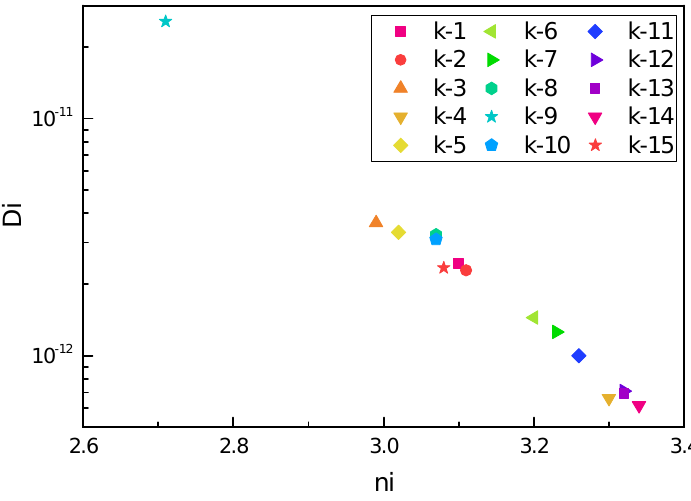
Figure 12. Values of D i and n i of test